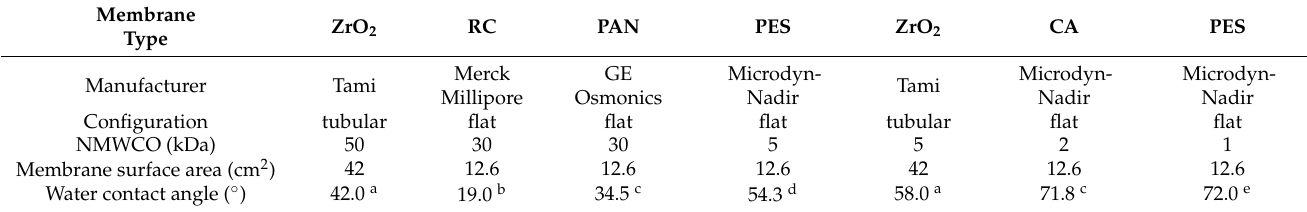
Table 1. Characteristics of selected